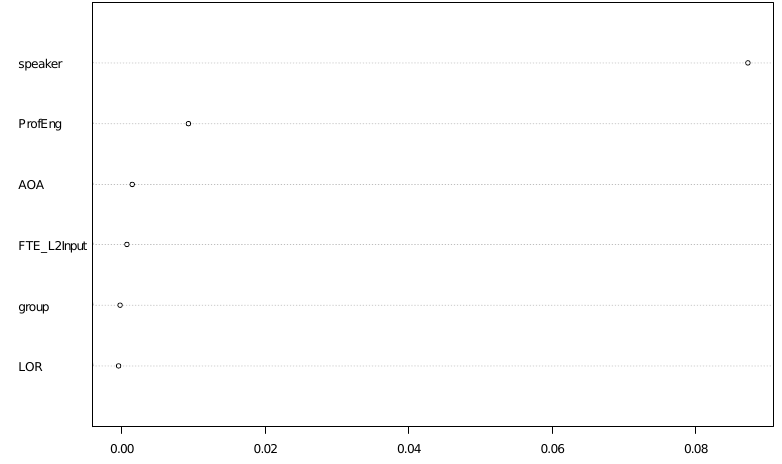
Figure 6. Random forest including AOA, bilingual group, LOR, L2 proficiency and FTE of L2 input.